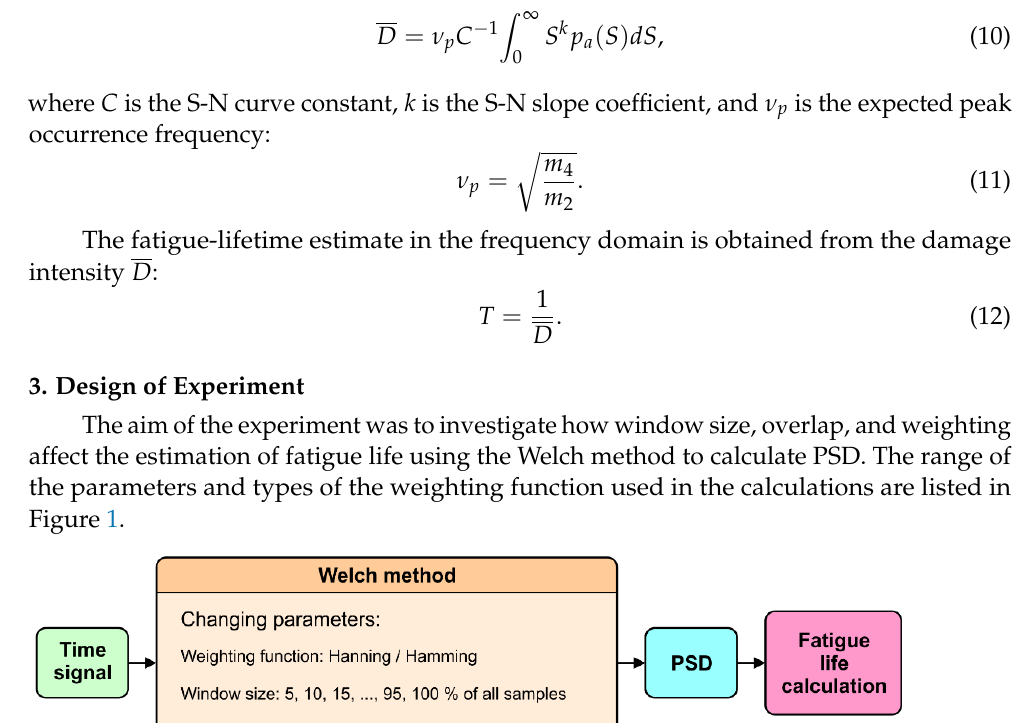
Figure 2. Synthesized PSD using constants (a), constants with linear connection (b), and constants with quadratic connection (c), standardized PSD functions according to ISO 16750-3 (d) and EN 61373 (e)-(f). PSD was selected as the source of the time signals to ensure the same PSD shape for each time waveform during the simulation. Time courses were obtained by inverse Fou- rier transform with random phase shift. All calculations were performed in MATLAB.